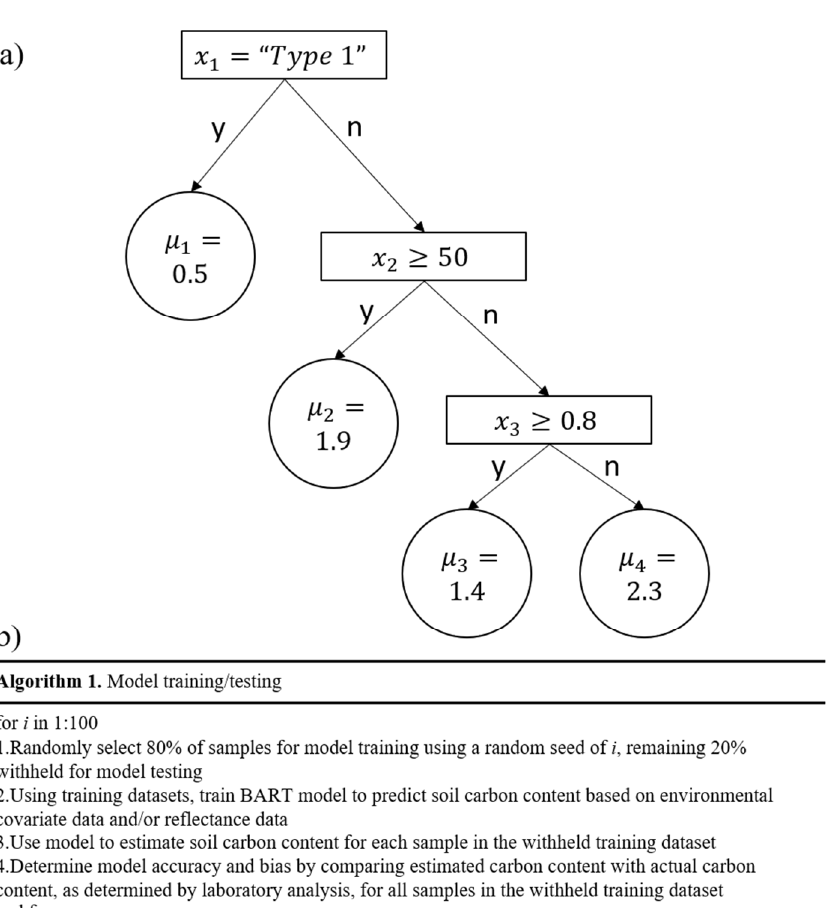
Figure 2. Conceptual diagram ( a ) of a regression tree model such as the type generated by the BART approach employed in this study. Coefficients µ i are estimated at each i th node based on binary split decision rules for a set of independent variables x = { x i ,…, x n }. Independent variables can be either categorical or continuous. Additionally ( b ) Algorithm 1 outlines the model and training stepwise process.